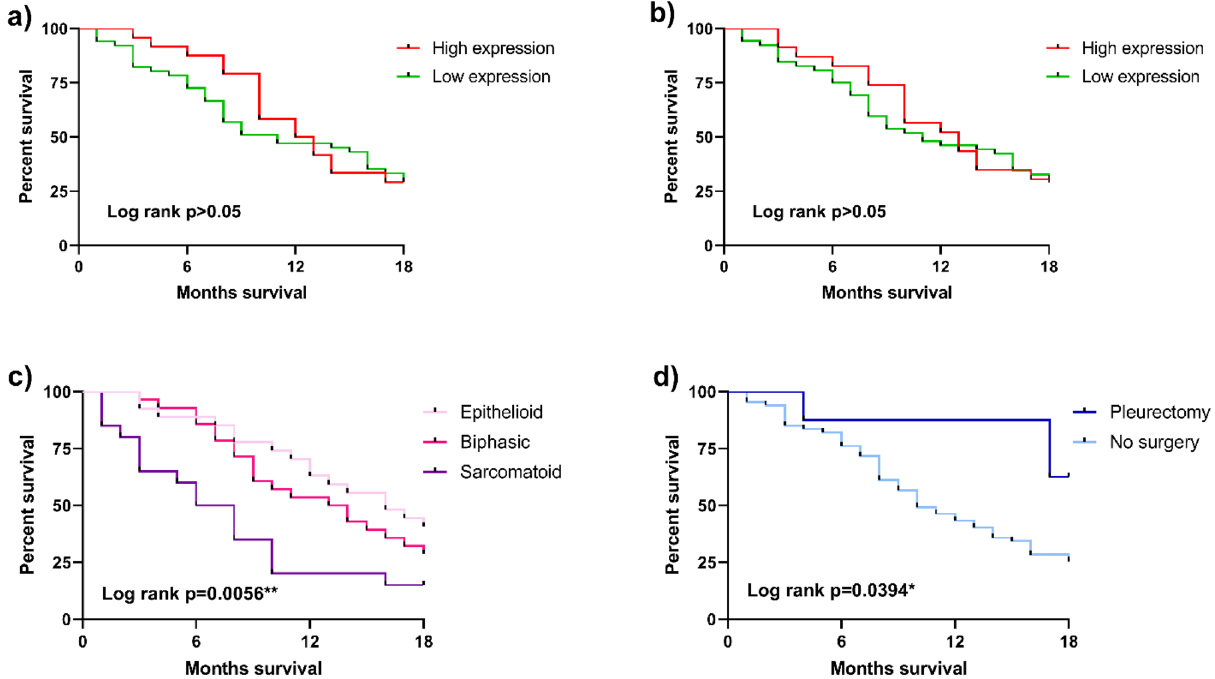
Figure 4. Overall survival (OS) outcome analysis at 18 months in MPM cohort. ( A ) Kaplan–Meier (KM) curves for OS in MPM patients related to miR-197-3p expression revealed by RT-qPCR (log-rank P > 0.05) and ( B ) ddPCR (log-rank P > 0.05). ( C ) Kaplan–Meier (KM) curves for OS in MPM patients related to histological subtype (log-rank ** P = 0.0056). ( D ) Kaplan–Meier (KM) curves for OS in MPM patients underwent to pleurectomy (log-rank * P =